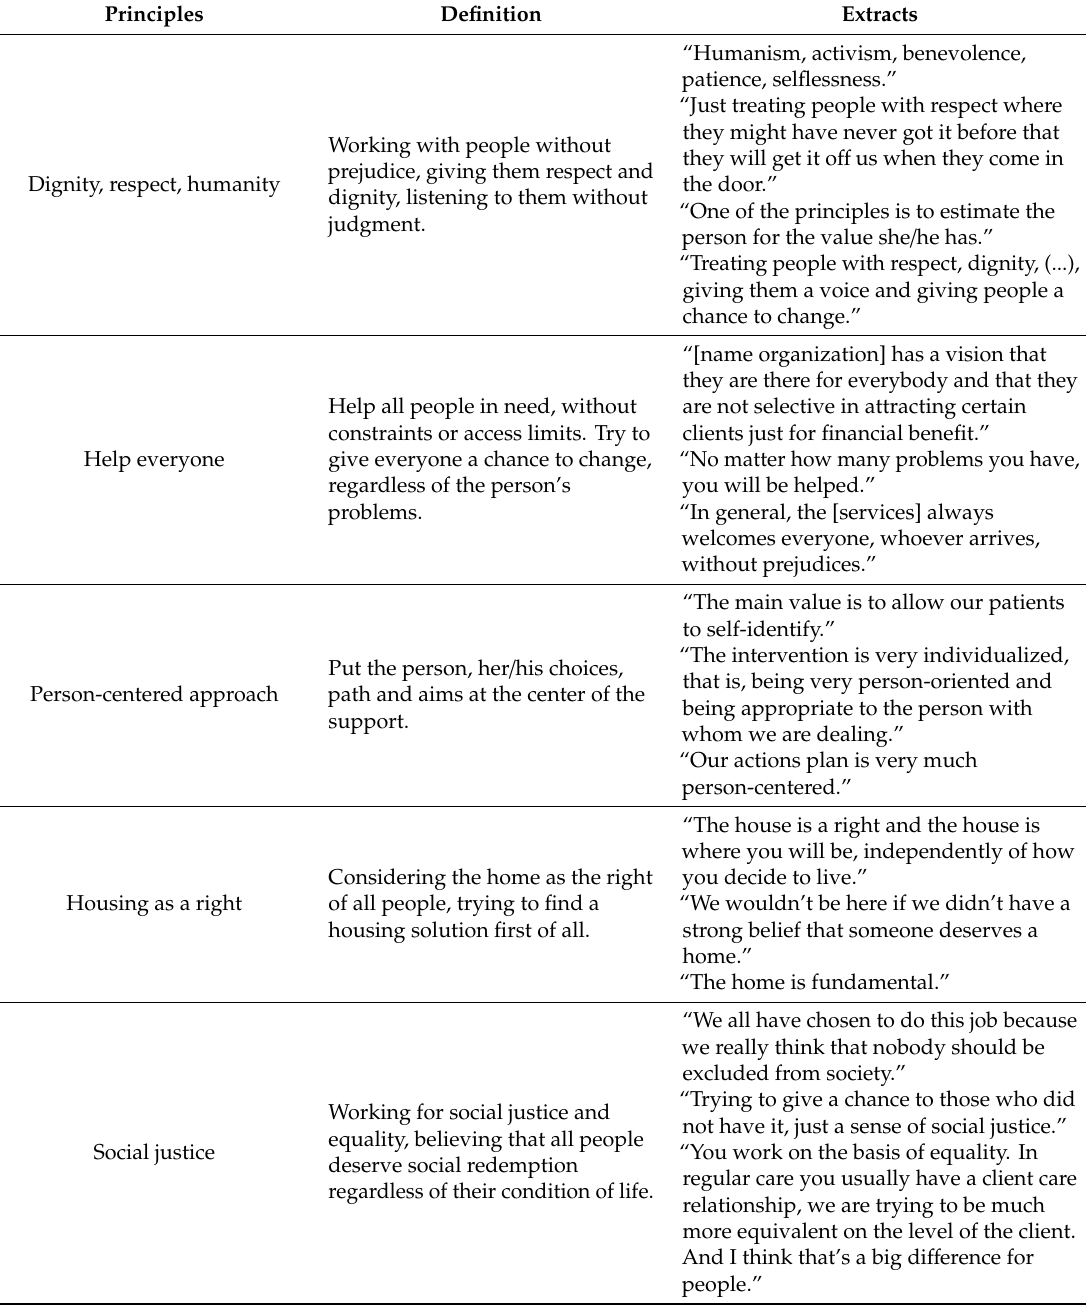
Table 2. Principles of providers working with people experiencing